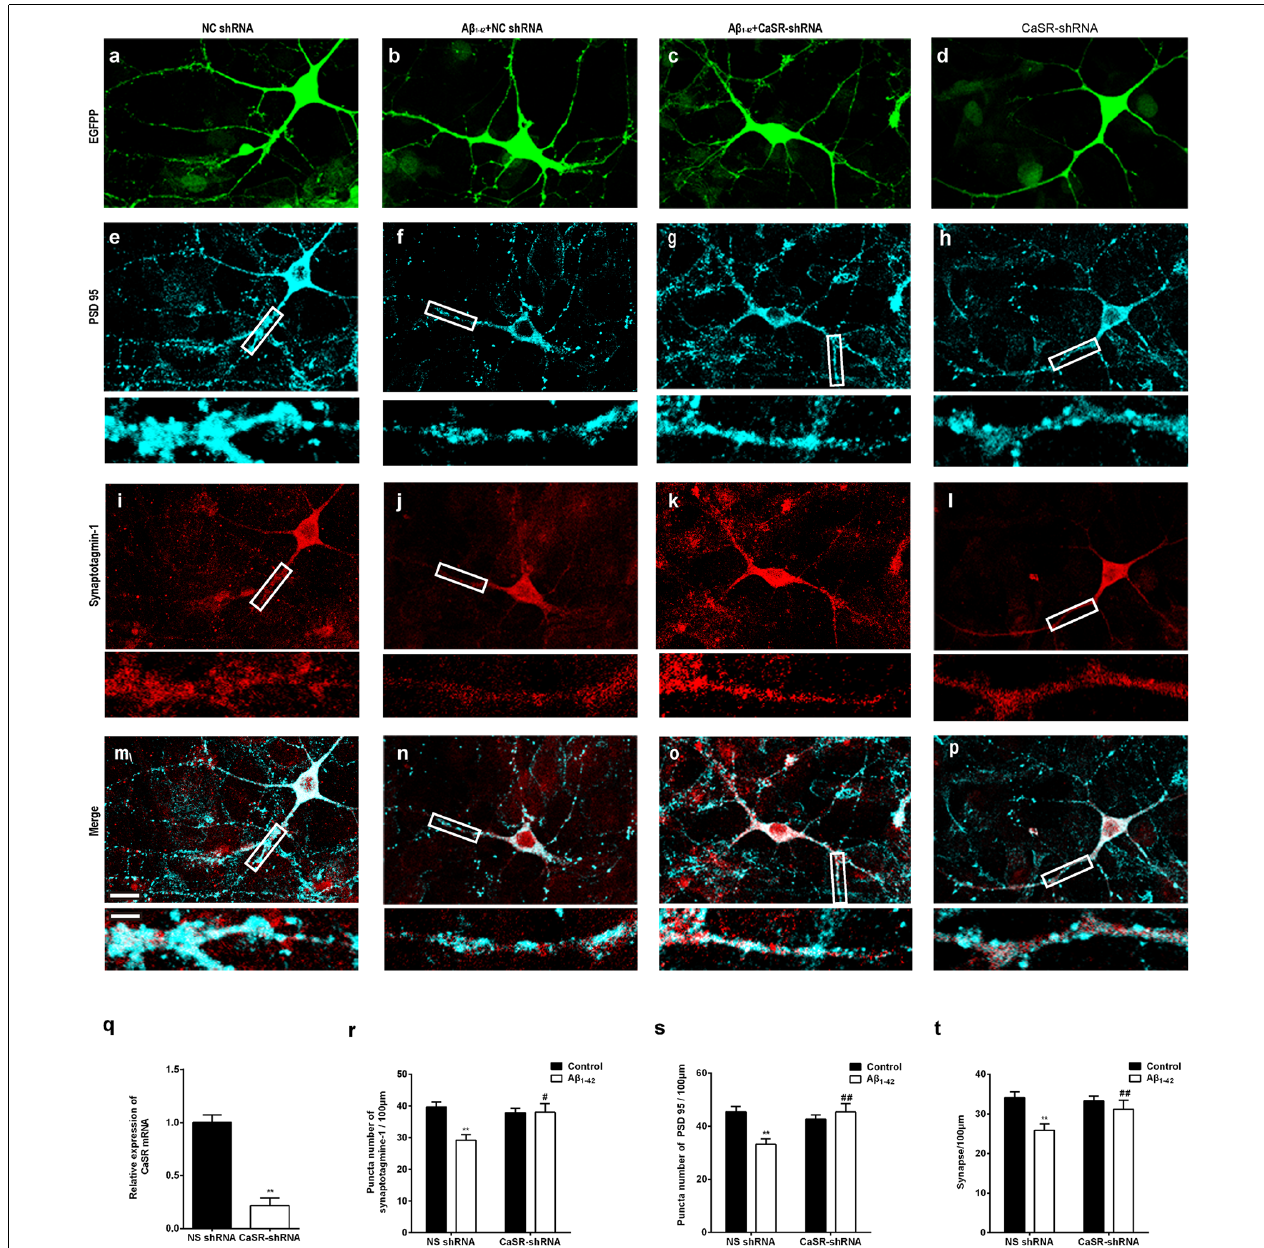
FIGURE 5 | Down-regulation of CaSR expression prevented synaptic impairment induced by oligomeric A β 1–42 in hippocampal neurons. Sample figures of the NC shRNA (A,E,I,M) , the 0.5 µ M A β 1–42 + NC shRNA group (B,F,J,N) , the 0.5 µ M A β 1–42 + CasR-shRNA group (C,G,K,O) , and the CasR-shRNA group (D,H,L,P) . Scale bar 20 µ m and 5 µ m. (Q) The expression level of CaSR was significantly down-regulated by CaSR-shRNA. ** P < 0.01 vs. NC shRNA group. (R,S) Quantitative comparison of the number of synaptotagmine-1-positive puncta and PSD 95-positive puncta of the four groups. (T) Down-regulation of CaSR protected hippocampal neurons from synapse loss induced by oligomeric A β 1–42. ** P < 0.01 vs. NC shRNA group, # P < 0.05 vs. A β 1–42 + NC shRNA group, ## P < 0.01 vs. A β 1–42 + NC shRNA group. Values represent mean ± SEM, n = 17–20 neurons from three independent primary cell culture